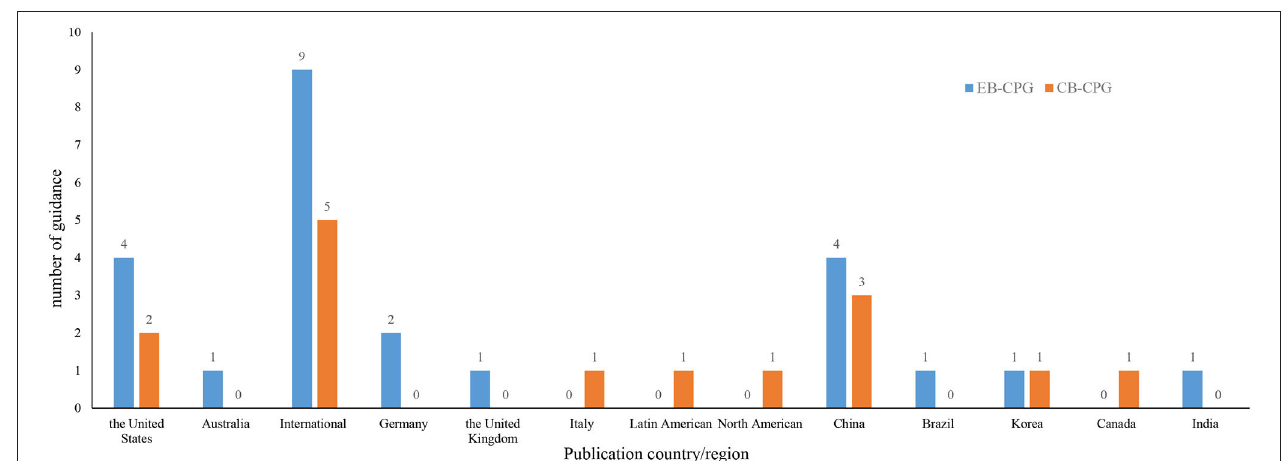
FIGURE 2 | Distribution of publication country/region in the guidelines included.